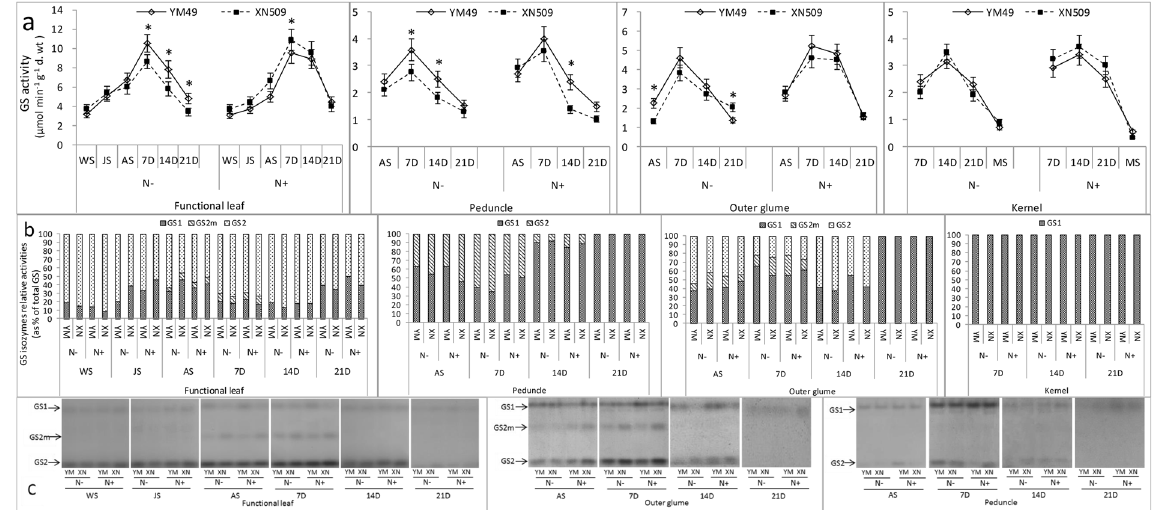
Figure 3. Glutamine synthetase (GS) activity and relative levels in various organs of two wheat genotypes. ( a ) GS activity. Data are the mean ± SE of three biological replicates. Asterisks ( * p < 0.05, LSD) indicate significant differences between YM49 (YM) and XN509 (XN) under the same nitrate conditions. Low nitrogen (N − ) and high nitrogen (N + ). ( b ) Relative activities of GS1 and GS2 isozymes of two wheat genotypes. Proportions were calculated after quantification of signals using gray-scale image analysis and Gel-Pro Analyser software (Version 4.0). ( c ) GS1 and GS2 isozymes in different organs of two wheat genotypes were separated by native-PAGE. Equal protein amounts were loaded in each lane (50 μ